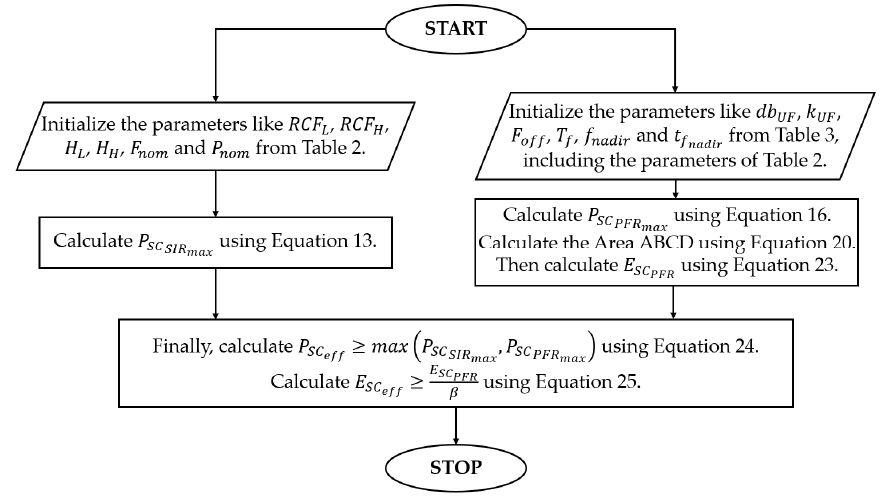
Figure 19. Flow chart for the sizing of the SC Energy Storage System.